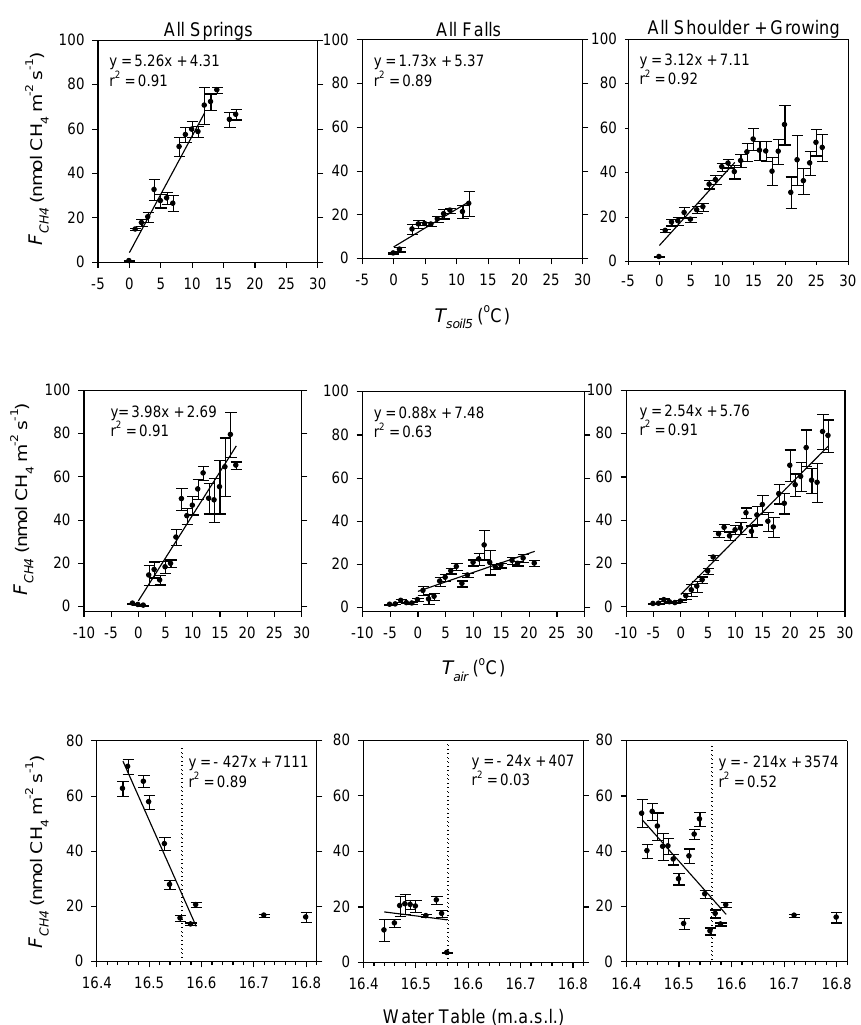
Water Table (m.a.s.l.) ± 1SE in response to T Fig. 5. Bin-averaged (1 ◦ C) 30min F CH soil5 and T air shown for all springs (DOY 150 to 190, 2008–2011), all falls 4 (DOY 260 to 320, 2008–2011) and all shoulder + growing seasons (DOY 150–320, 2008–2011). Bin-averaged (1cm water table height) ± 1SE in response to water table is shown for the same periods. Dotted line indicates the mean peat surface 30min F CH 4